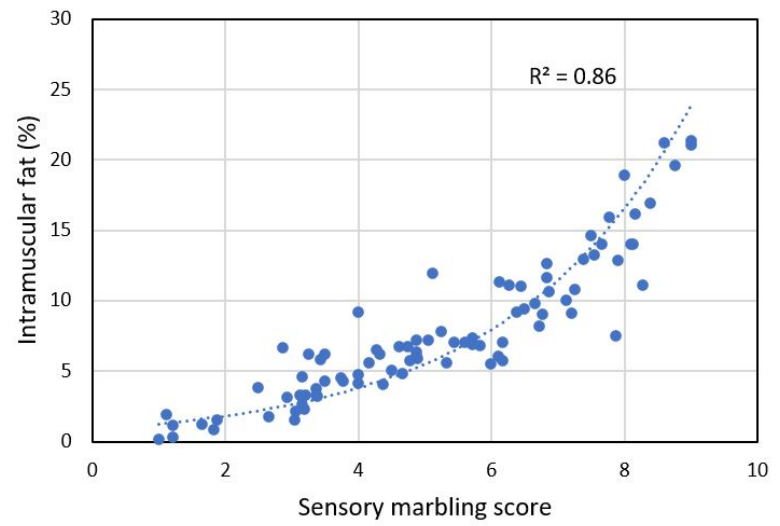
Figure 3. Relation between sensorial fat marbling scores and IMF for sliced loin steaks.